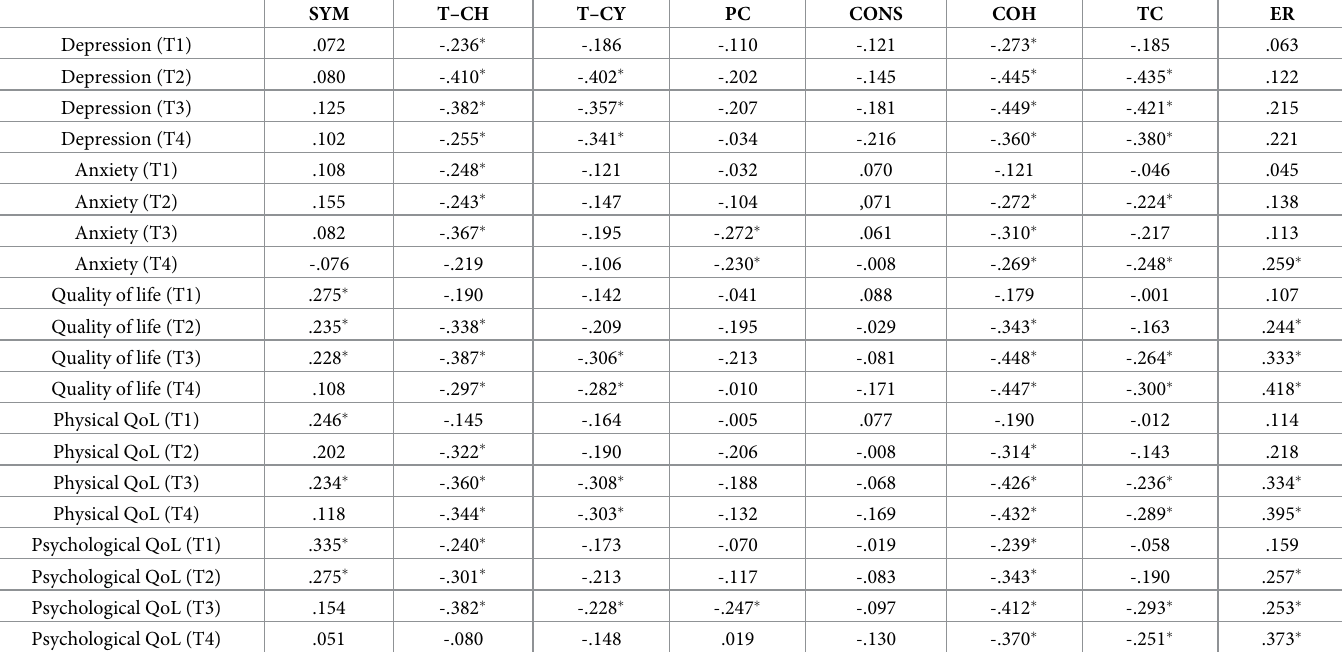
Cluster 1. Anxious Illness Perception (30 patients)–patients from this cluster scored high on perceived symptoms, and negative consequences of illness. They obtained moderate scores on personal control and illness coherence. They scored high on the level of negative emotions. Table 4. Pearson correlation coefficients between IPQ-R subscales, HADS (depression and anxiety) and MSIS-29 with subscales (quality of life, physical QoL and psychological